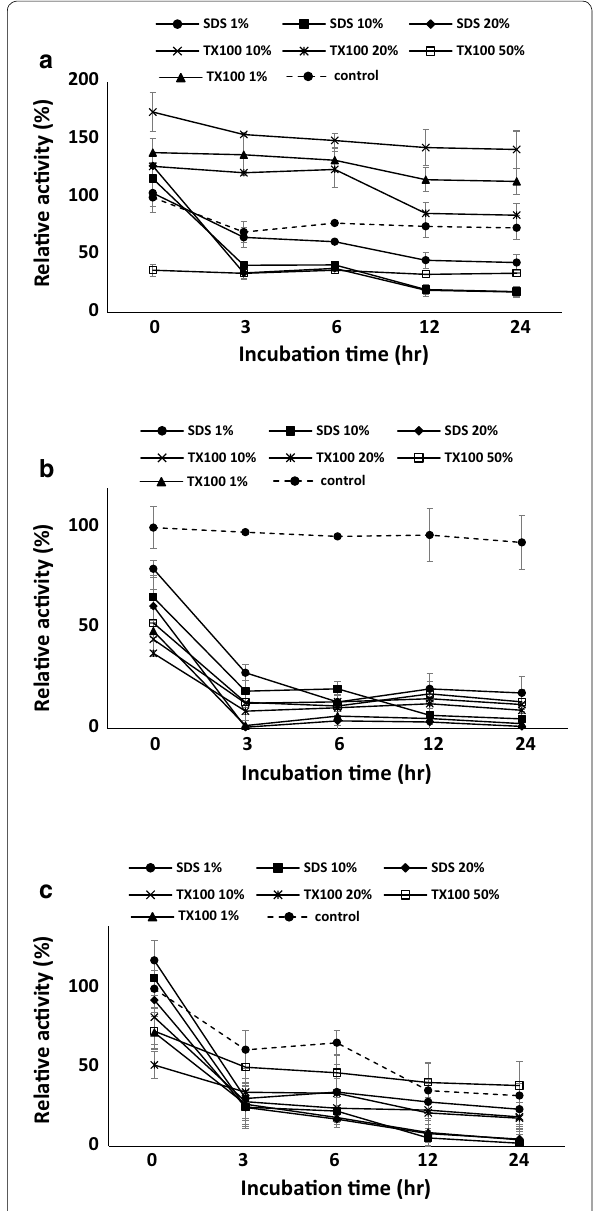
Fig. 7 Stability of Tl LipA ( a ) and commercial lipases HA ( b ) and HB ( c ) after incubation with SDS or Triton X100 for various